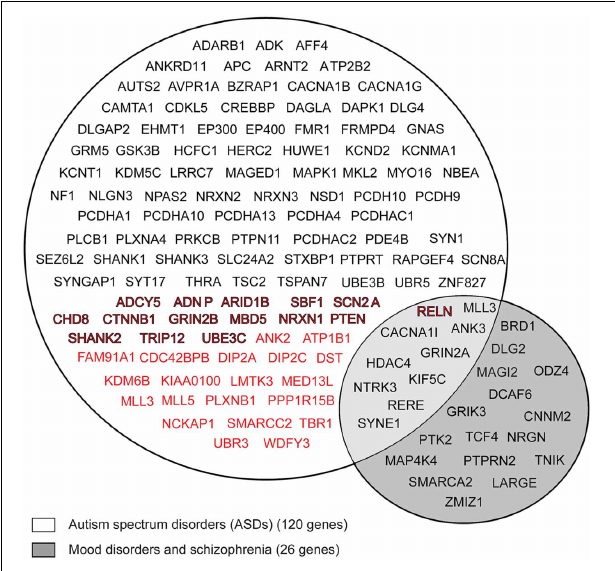
FIGURE 2 | Venn diagram of FMRP mRNA targets associated with autistic spectrum disorder (ASD), schizophrenia (SCZ) and mood disorder (MD). FMRP neuronal target genes (1169) were compared with de novo gene disruptions (nonsense, splice and frameshifts) reported in GWAS are associated with ASD, as previously described (Iossifov et al., 2012; Neale et al., 2012; O’roak et al., 2012b; Sanders et al., 2012), the 528 genes from the SFARI (https://sfari.org/resources/sfari-base) and the 304 genes from the AutDB databases (http://autism.mindspec.org/autdb/Welcome.do). Approximately 120 FMRP target genes were associated with ASD (in black). Among the 120 target genes, included 35 genes were identified from the GWAS (in red) and 100 genes were identified from the two databases (in black). Fifteen genes showed overlap between the GWAS, the SFARI, and AutDB databases (in black/red color). The 1169 FMRP target genes were compared with the genes associated with SCZ and MD in the NHGRI GWAS database (http://www.genome.gov/gwastudies/) and 26 common FMRP targets were